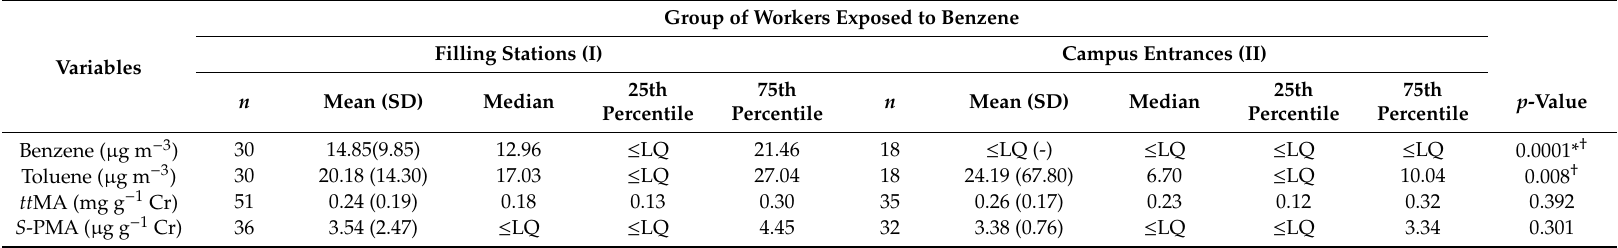
Table 2. Results of the environmental and biological evaluation of exposure of the two groups of workers exposed to benzene.